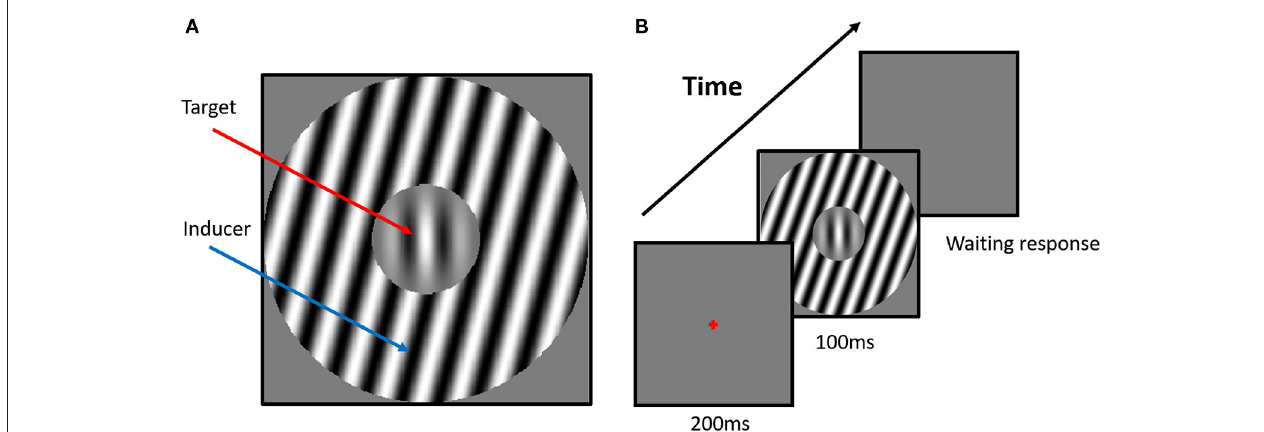
FIGURE 1 | Example stimuli and experiment scenario. (A) The stimulus configuration for the tilt repulsion condition. In this case, the orientation of the surround inducer is + 15 ◦ , and the central target is oriented vertically (0 ◦ ), which induces a repulsion in the perceived orientation of the center grating, now appearing to be tilted left of vertical. (B) The scenario of the tilt illusion (TI) experiment. The classical one-interval task was used in the current experiments. The surround orientation could have one of seven values ( − 75 ◦ , − 30 ◦ , − 15 ◦ , 0 ◦ , + 15 ◦ , + 30 ◦ , + 75 ◦ ) relative to the orientation of the center grating, and we manipulated the center orientation in each trial with respect to vertical according to the participant’s responses to measure each subject’s perceived vertical.